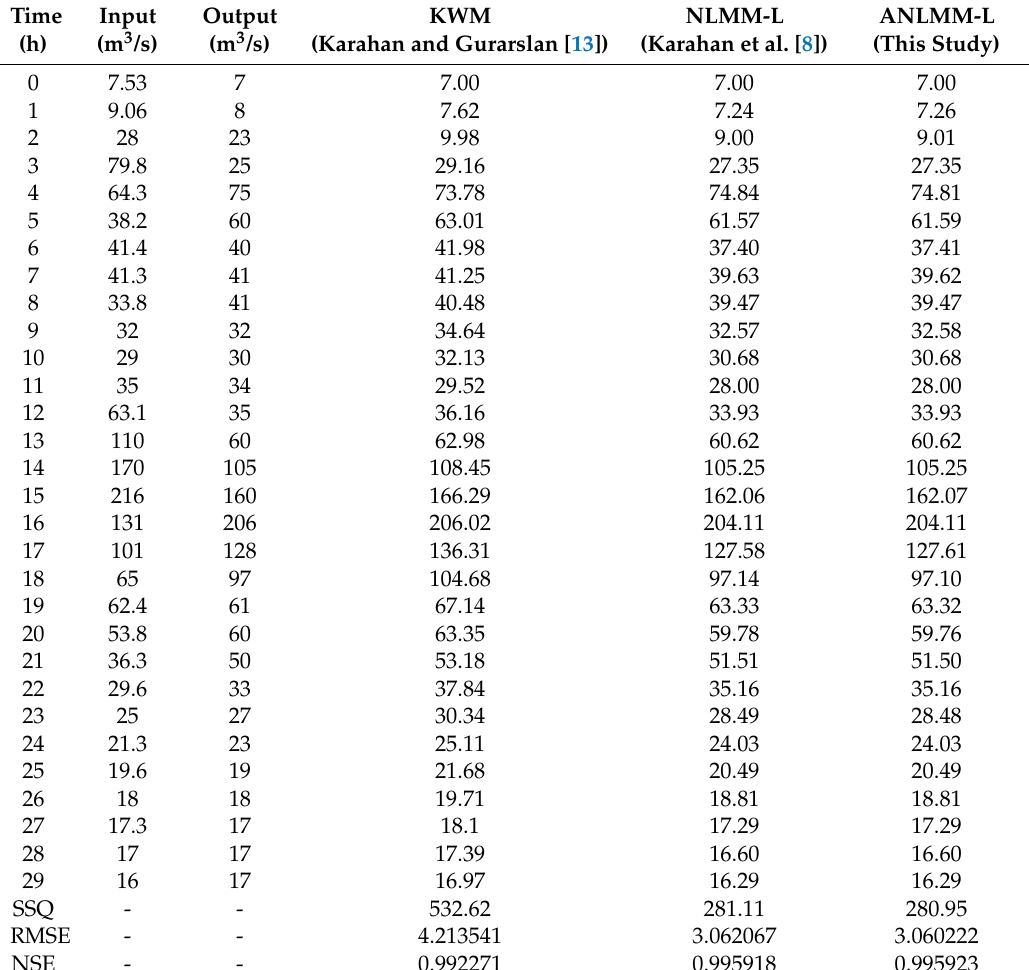
Table 7. Comparison of the outflow hydrographs calculated for the Sutculer flood